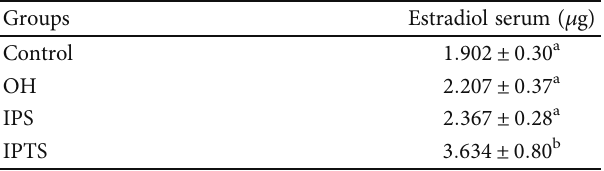
Control: control rats with standard feed, OH: OVx rats with standard feed, IPS: OVx rats with instant pumpkin cream soup feed, and IPTS: OVx rats with instant pumpkin cream soup enriched with tempeh. Values are the mean ± standarddeviation (SD) of the three replicates. Di ff erent letters in the same column indicate signi fi cant di ff erences ( p > 0 : 05 ) between treatments.